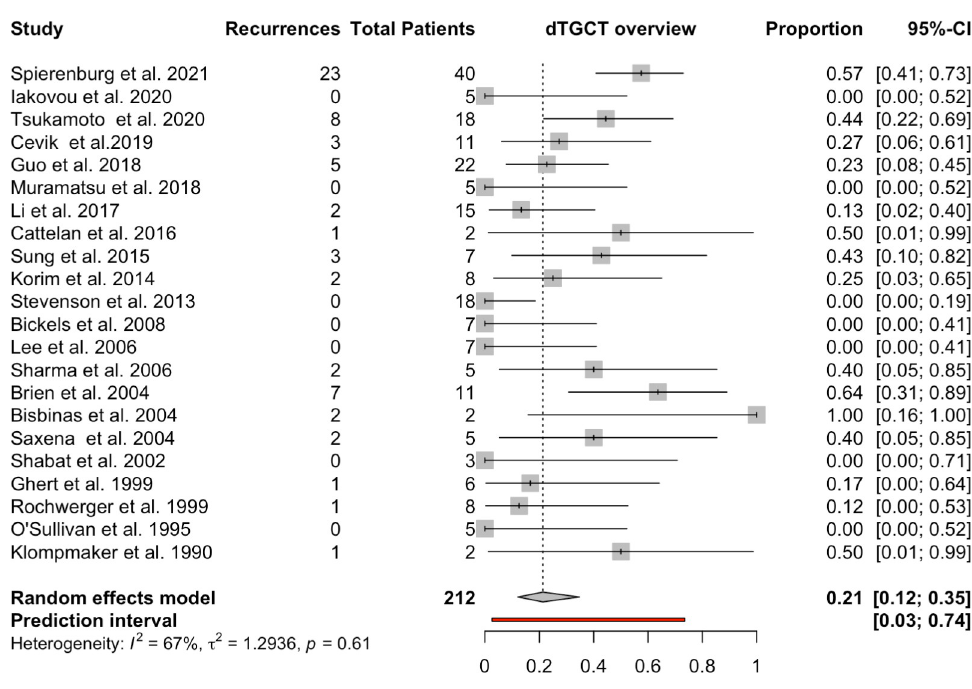
Fig 4. Recurrences in patients with